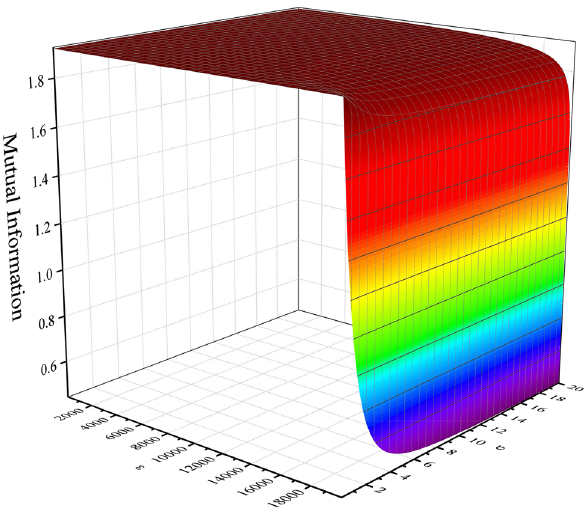
Fig. 6 The mutual information I of the final state of two entangled qubits as a function of the volume ε and the rapidity σ of the cosmic expansion. The parameters of the two qubits are the same. The qubit energy level difference is (cid:15) = 2, the inner product of the mode func- tions, defined in Eq. (21), is μ = 0 . 1, the mass of the scalarfield particle ( | 01 (cid:7) + | 10 (cid:7) is m = 0 . 01. The initial state of the qubits is 1 √ 2